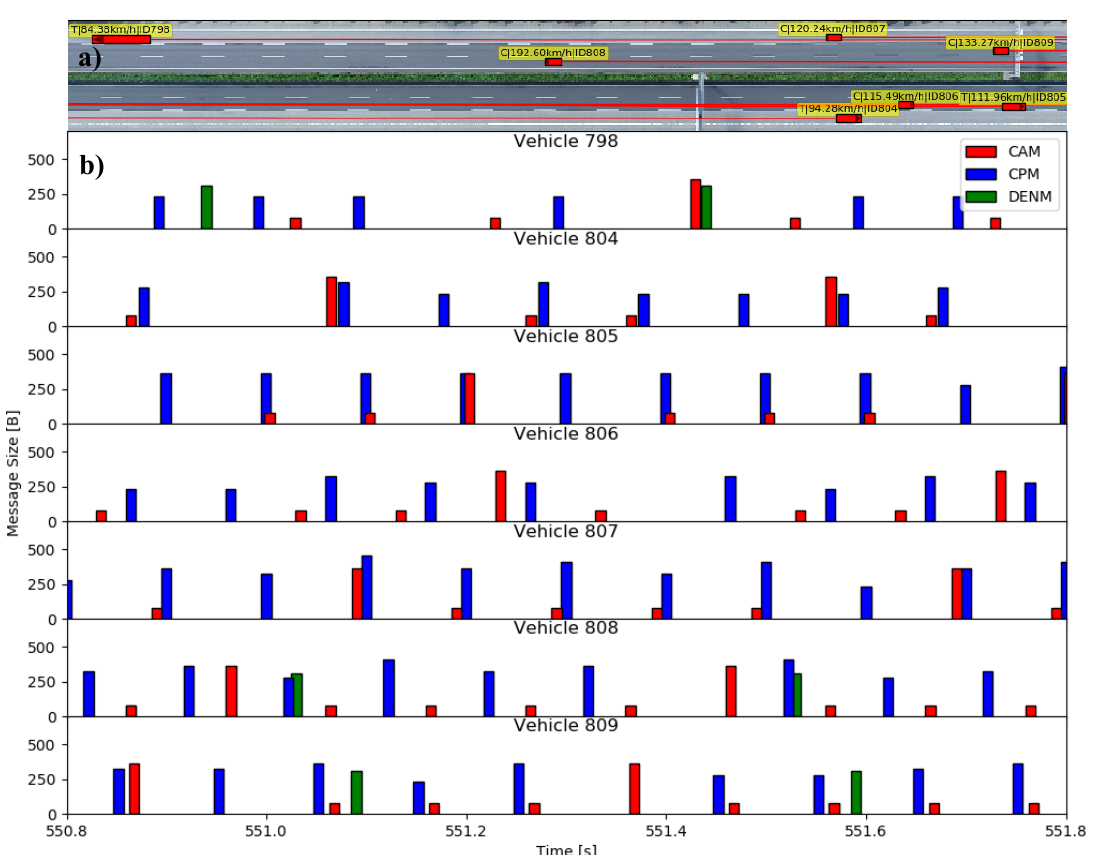
Figure 7. Message generation of the ETSI stack for the low-density scenario: ( a ) Vehicles on a highway section; ( b ) Corresponding generated messages over time. The temporal extension of the messages is only for visualization purposes.